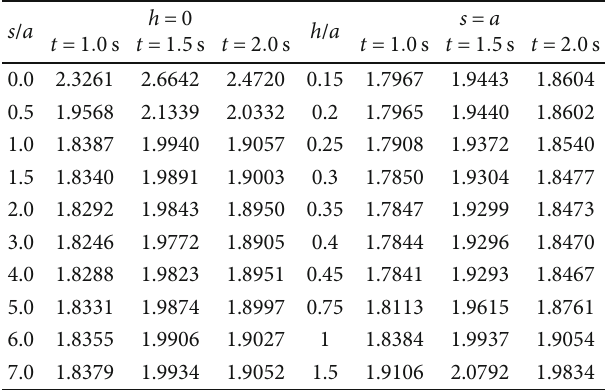
3 ) (a)s =0 (b)s ΙΙ under di ff erent s / a and h / a . d